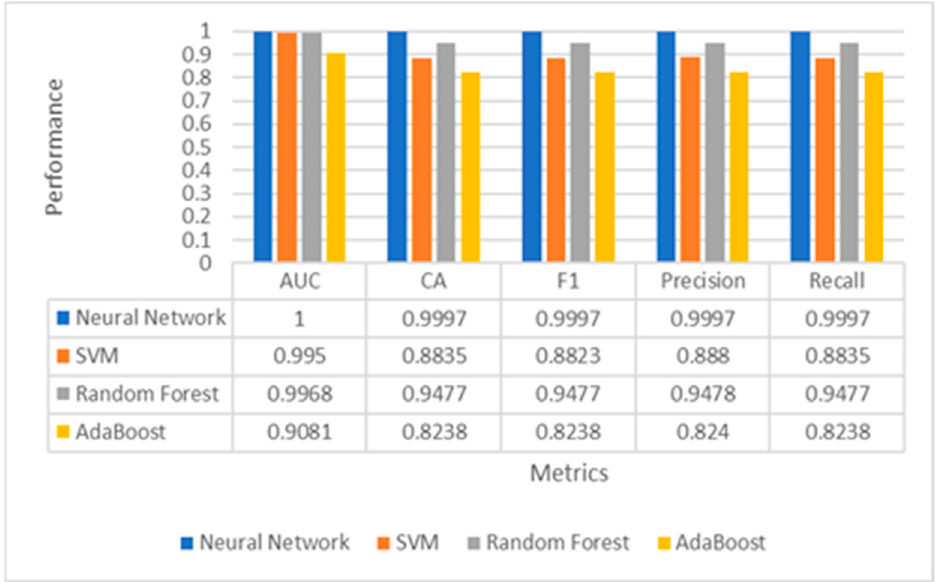
Figure 9. Performance evaluation of multiple classifiers for hand gesture recognition using only 60 features. Table 4. Ablation study results on the MNIST dataset.